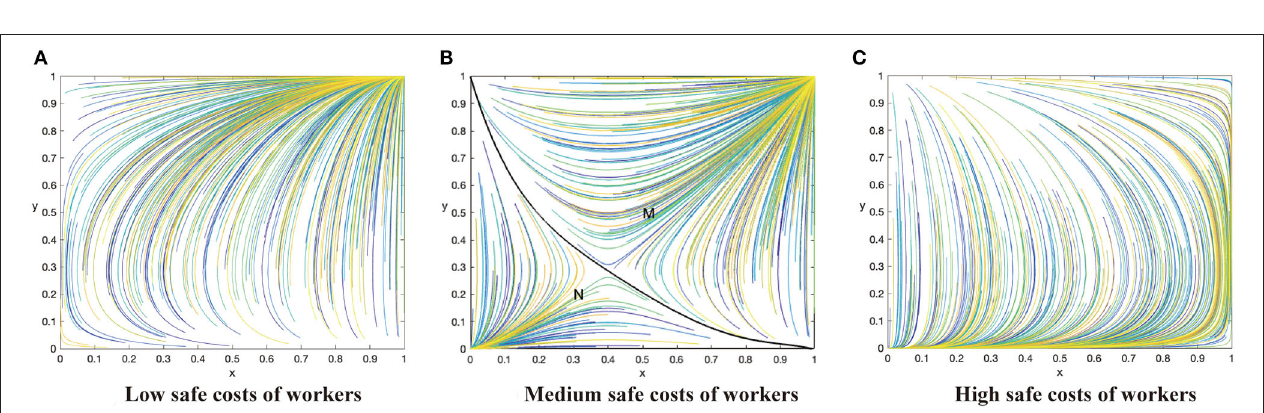
FIGURE 3 | The dynamic evolutionary path of the game in sub-category 3-1, including low safety costs to workers (A) , high safety costs to workers (C) , and medium safety costs to workers (B) .